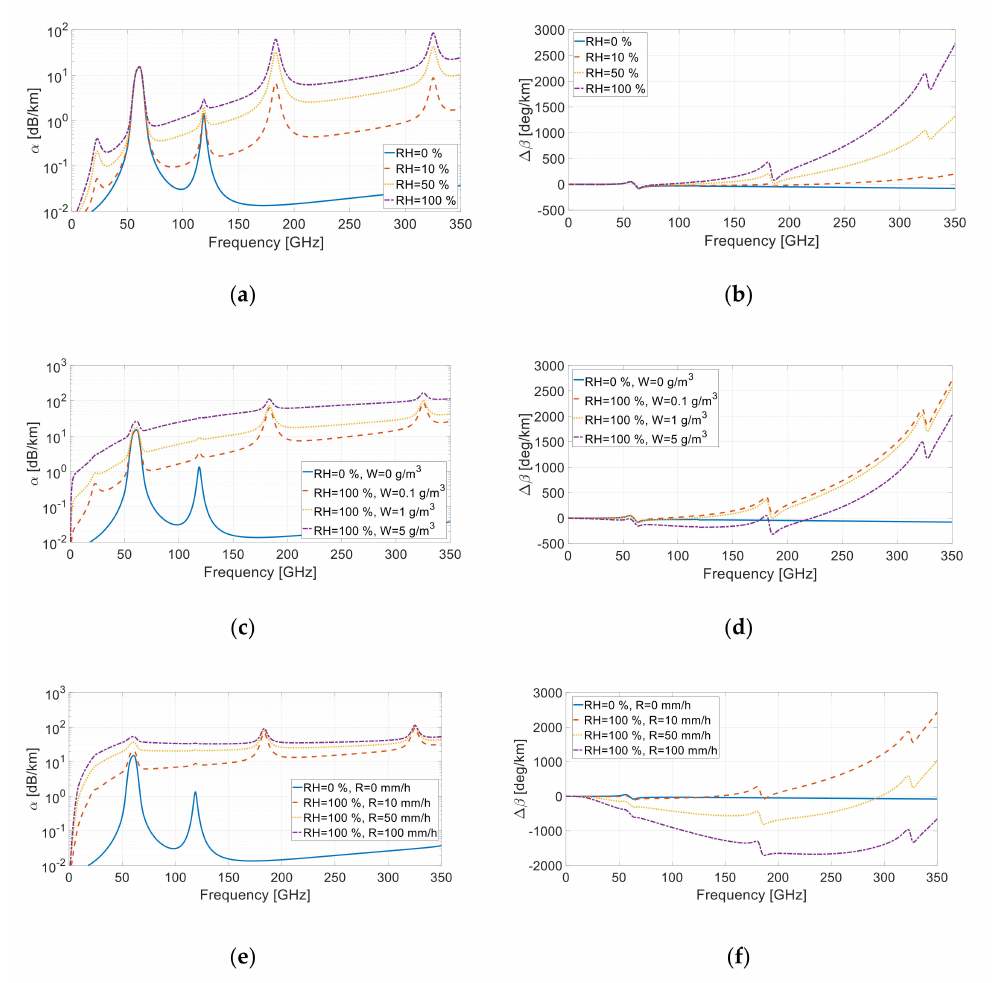
Figure 2. Attenuation factor ( a , c , e ) and incremental phase dispersion factor ( b , d , f ) in di ff erent weather conditions: ( a , b ) show the relative humidity RH [%] e ff ect ( c , d ) show the e ff ect of suspended droplets via the liquid water content W [g / m 3 ] and ( e , f ) are for rainy conditions, where R is the rainfall rate in [mm /